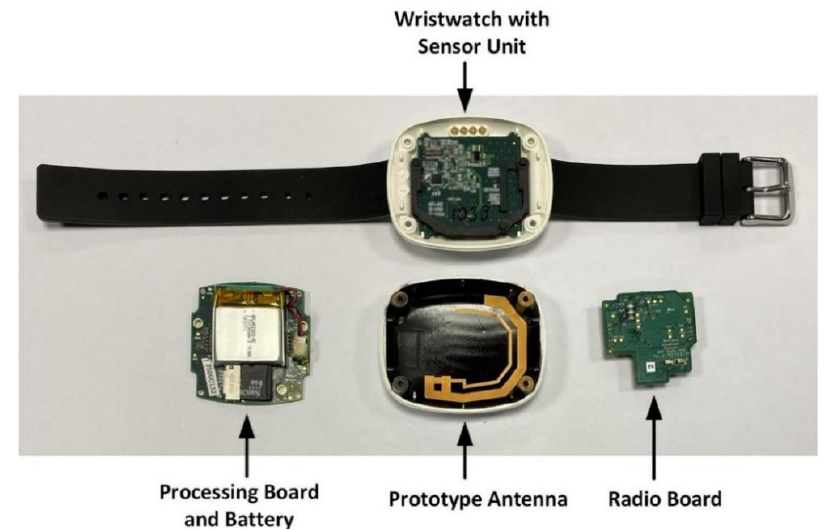
Figure 13. Wristwatch model assembly.